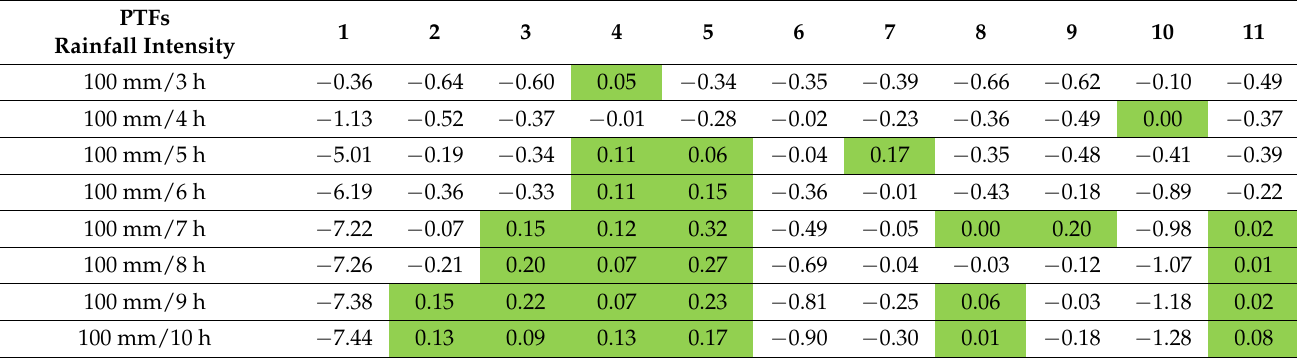
Table 6. Spatial similarities (SPAEF values) between the simulated patterns of DPR (i.e., for all PTF combinations and synthetic rainfall intensities) and the reclassified reference runoff process map. Positive values are in